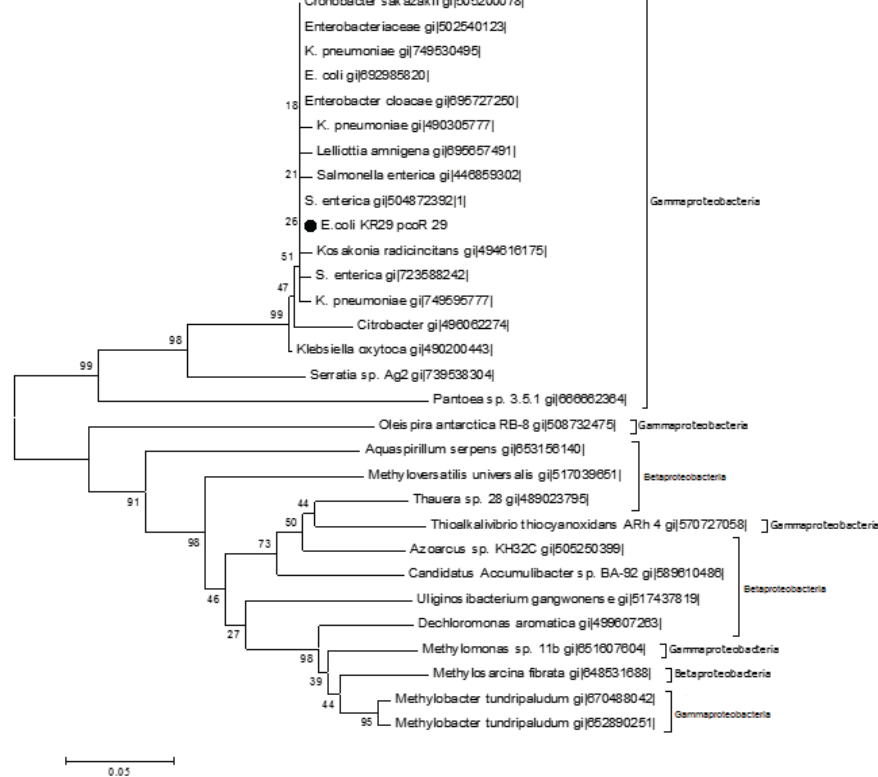
Figure 7. The evolutionary history was inferred using the Neighbor Joining Method